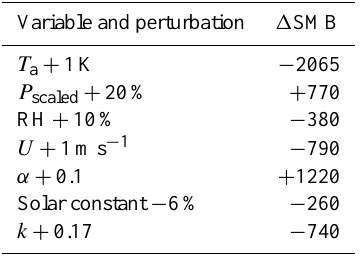
Table 7. The (cid:49) SMB (mmw.e.yr − 1 ) to perturbations in surface cli- mate and short-wave radiation terms. While the values shown are the average change in SMB per year for both positive and nega- tive perturbations in each climate variable, for clarity, (cid:49) SMB is ex- pressed as the SMB response to an increase in a given input variable or